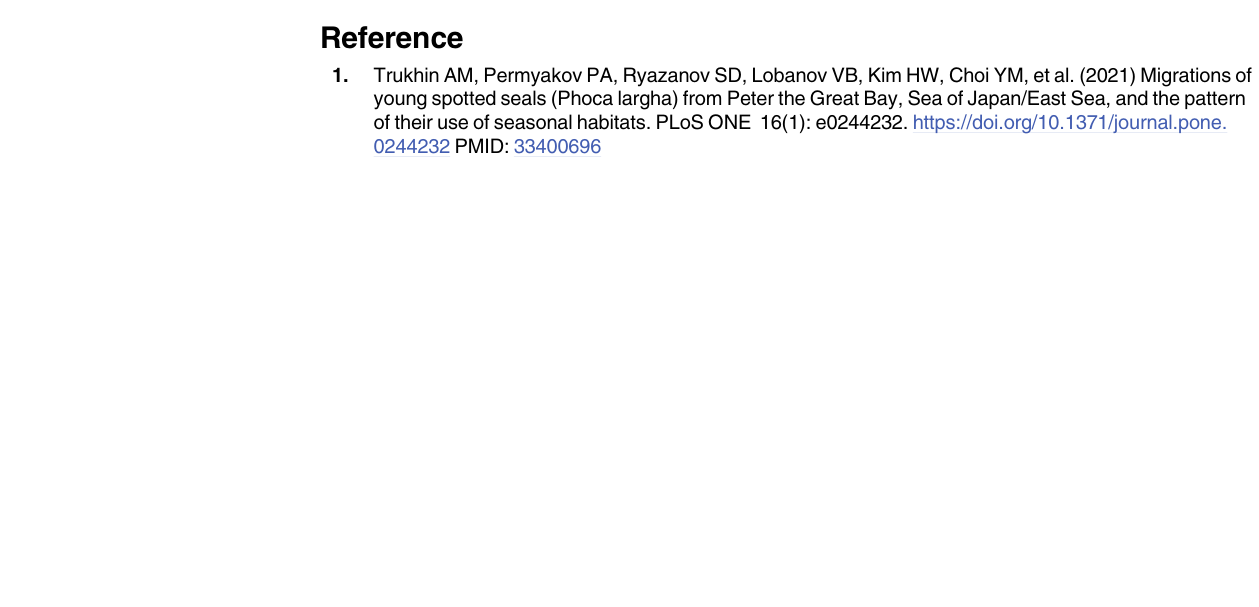
Fig 8. Winter habitats of underyearling male #148661. The numbers of the hot areas are the same as in Fig 3.